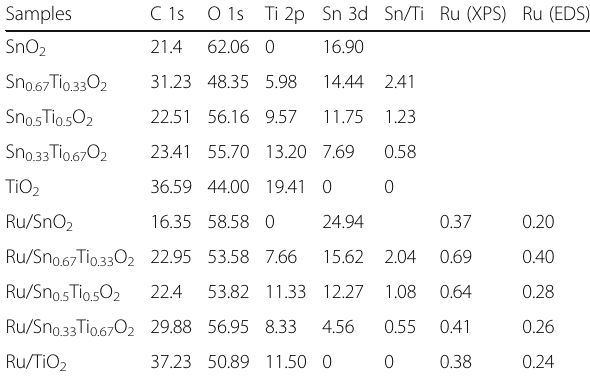
Table 2 The surface compositions by XPS and bulk compositions by EDS of the Sn x Ti 1 − x O 2 supports and Ru/Sn x Ti 1 − x O 2 catalysts Samples